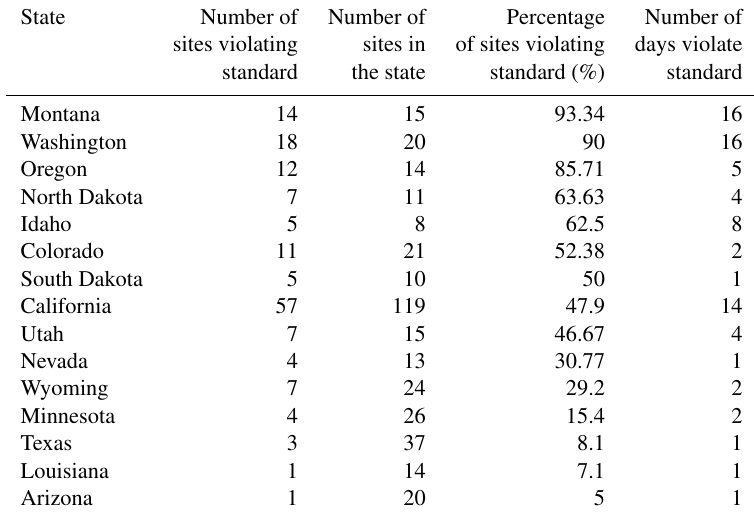
Table 3. Statistics of 15 states that violate EPA standards (35µgm − 3 ) during the 17d wildfire period. State Number of Number of Percentage Number of sites violating sites in of sites violating days violate standard the state standard (%) standard Montana 14 15